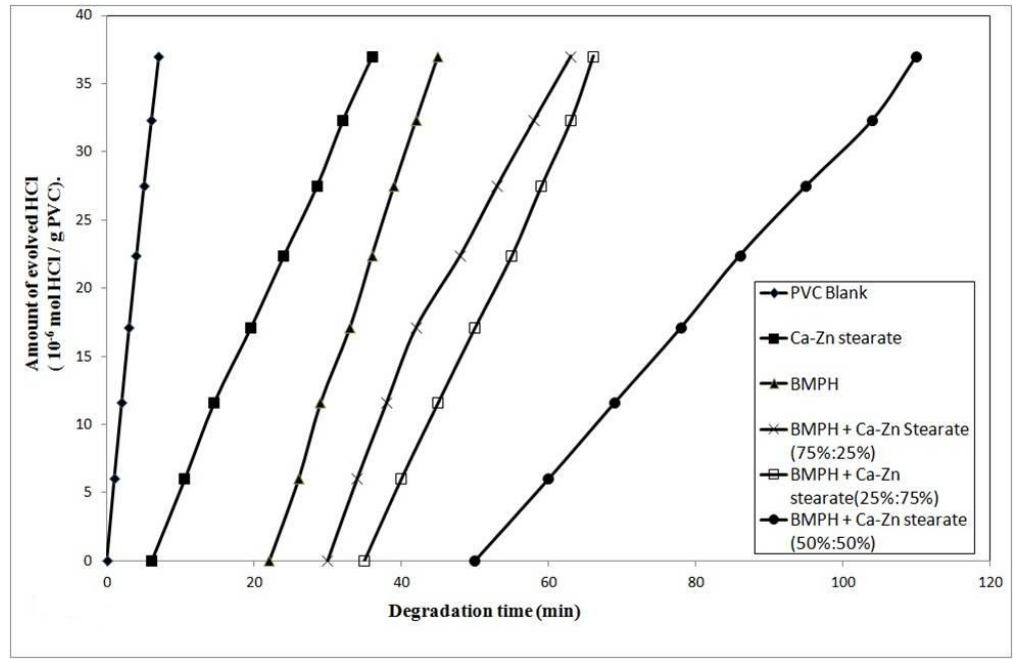
Figure 4. Dehydrochlorination rate of rigid PVC (BMPH stabilizer was mixed with Ca-Zn stearate), at 180 °C, in air, in the presence of 2 mass % of mixed stabilizers.